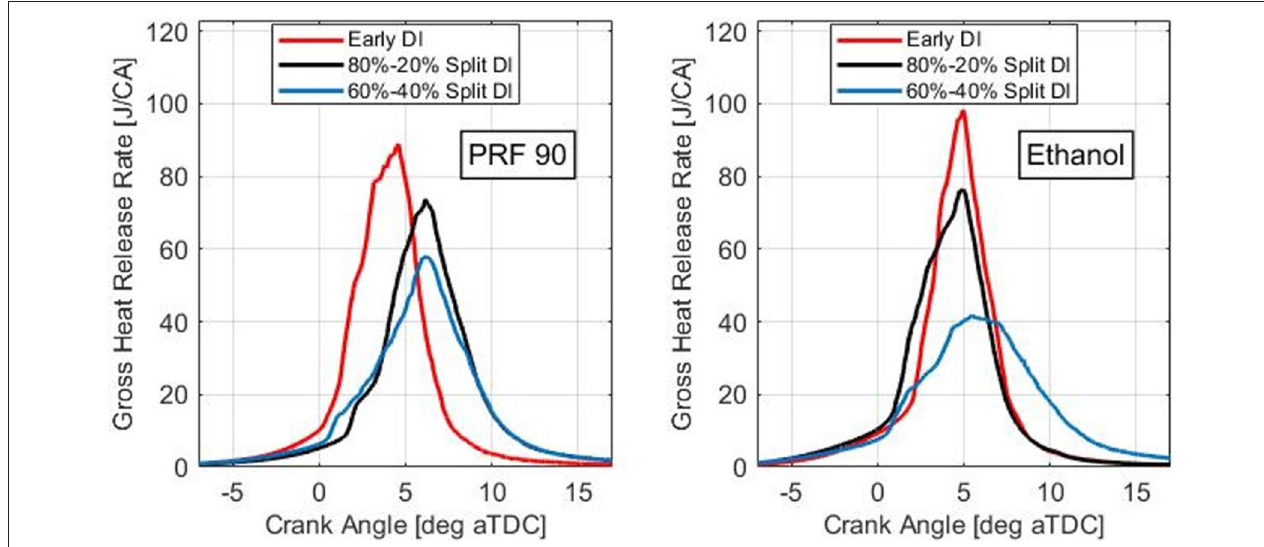
FIGURE 5 | Effect of fuel injection split fraction on the burn duration for PRF90 vs. ethanol. Injecting higher fuel fractions in the late injection elongates the burn duration due to the increased mixture stratifcation. For ethanol, the burn duratin increases more than PRF90.